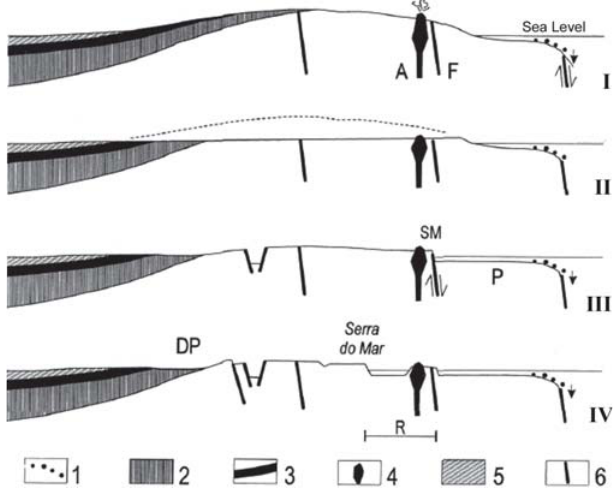
Fig. 5 . Schematic diagram of origin and erosional SE-NW re- treat of Serra do Mar coastal range in region between inland Paraná basin, and the Santos basin, coast of SE Brazil. 1- Eroded Senonian uplift, allowing deposition in both Santos and Paraná basins. Alkaline volcanism (A); Santos Fault (F). 2- Development of the Japi Erosional Surface at the end of Senonian. 3- Paleocene deformation of the Japi Surface (iso- static adjustment). Serra do Mar (SM) is generated at Santos Fault (F), system of continental rifts originated and continen- tal platform formed in coast (P). 4- Erosional retreat (R) of Serra do Mar toward present position. The approximate posi- tion of Depressão Periférica is indicated (DP). Alkaline intru- sions represent islands. Conventions: 1. Santos formation deposits, 2. Phanerozoic cover beneath the Serra Geral ba- salt, 3. Serra Geral Formation, 4. Alkaline bodies, 5. Bauru Group, 6. Faults (from Almeida & Carneiro, 1998).